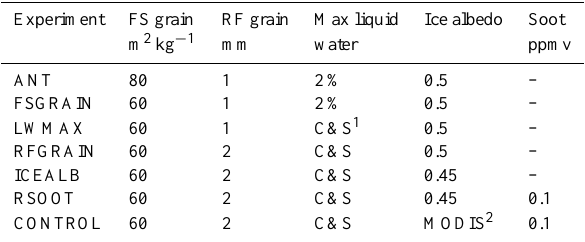
Table 1. Summary of the model settings applied in the various sim- ulations with RACMO2.